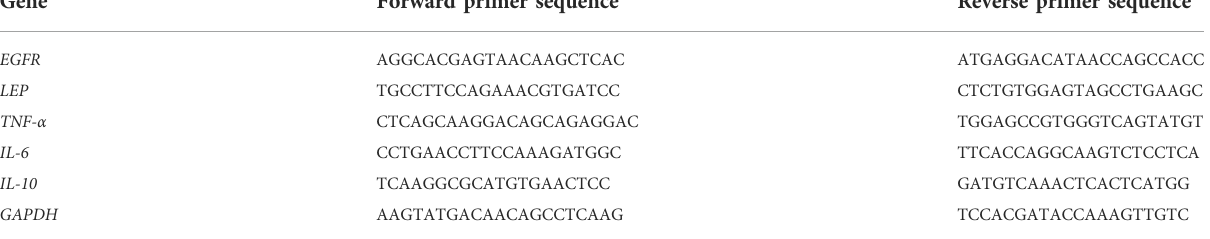
TABLE 2 Sequences of the qRT-PCR primers used for each